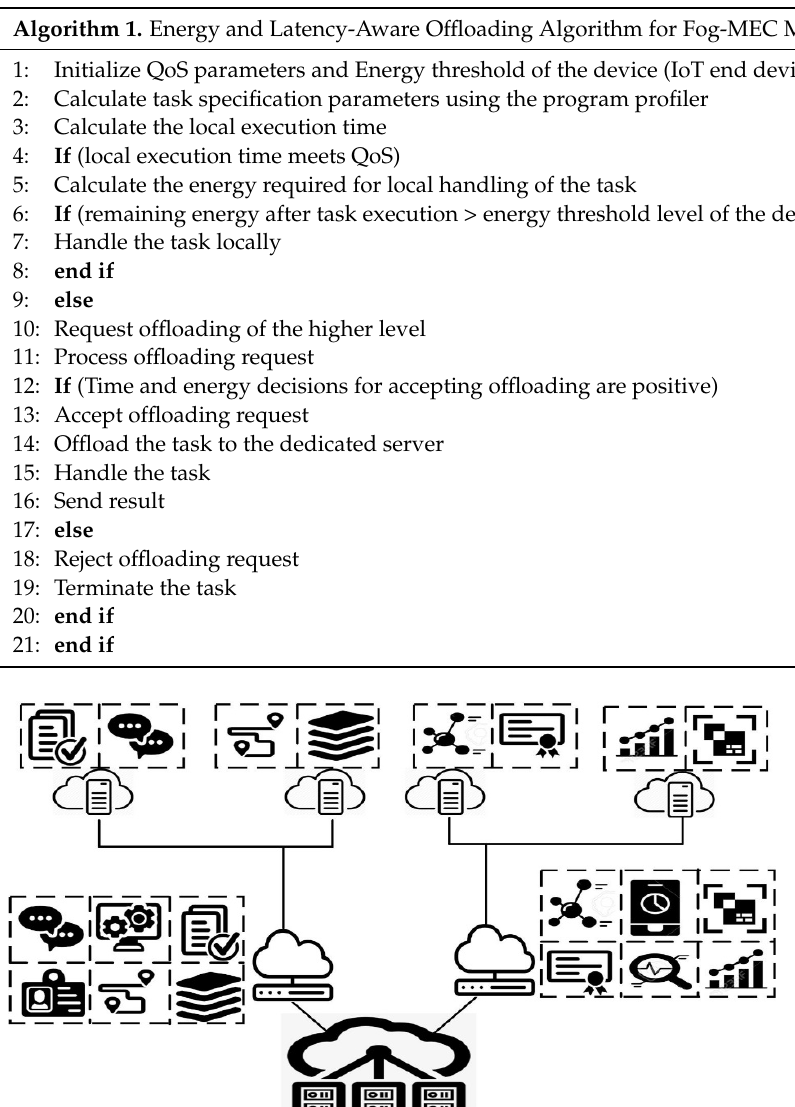
Figure 4. Levels of offloading of the proposed fog-MEC scheme.